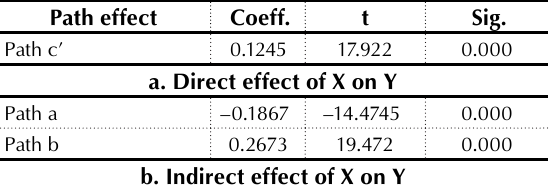
Table 6. Inconsistent mediation